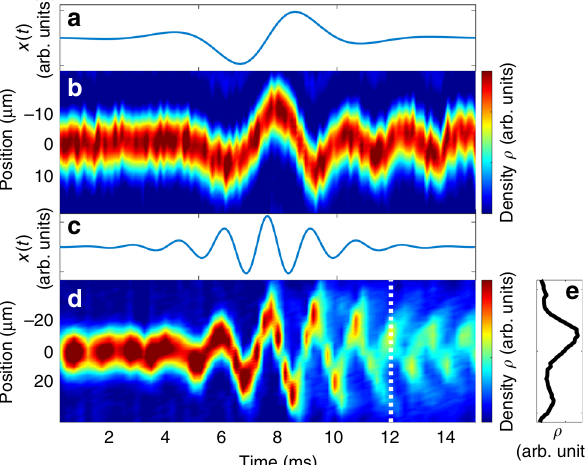
Fig. 4 Sub-cycle dynamics during off-resonant and near-resonant pulses. a Trap minimum position as a function of time for a pulse with τ = 3.76 ms, f = 200 Hz, A = 3 μ m, and ϕ = π . b Post-time-of- fl ight integrated spatial density distribution versus trap turn-off time during the off-resonant pulse depicted in a . Here ν x = 450 Hz. c Trap minimum position as a function of time for a pulse with τ = 3.76 ms, f = 550Hz, A = 1.5 μ m, and ϕ ¼ 3 π Post-time-of- fl ight integrated spatial density distribution versus trap turn- off time during the near-resonant pulse depicted in c . Here ν x = 600Hz. e Density distribution at the time indicated by the dashed line in d . Peaks